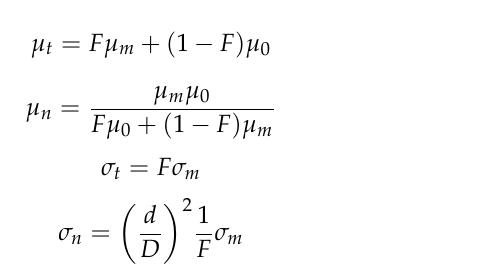
normal and tangential directions to characterize the anisotropy of the laminated structure.